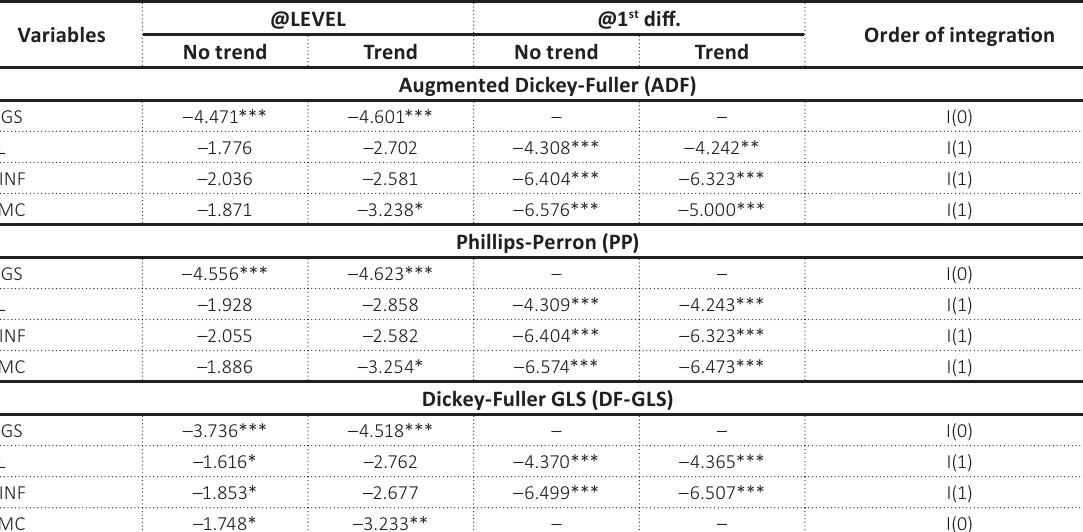
Source: Authors’ computation using EViews 10